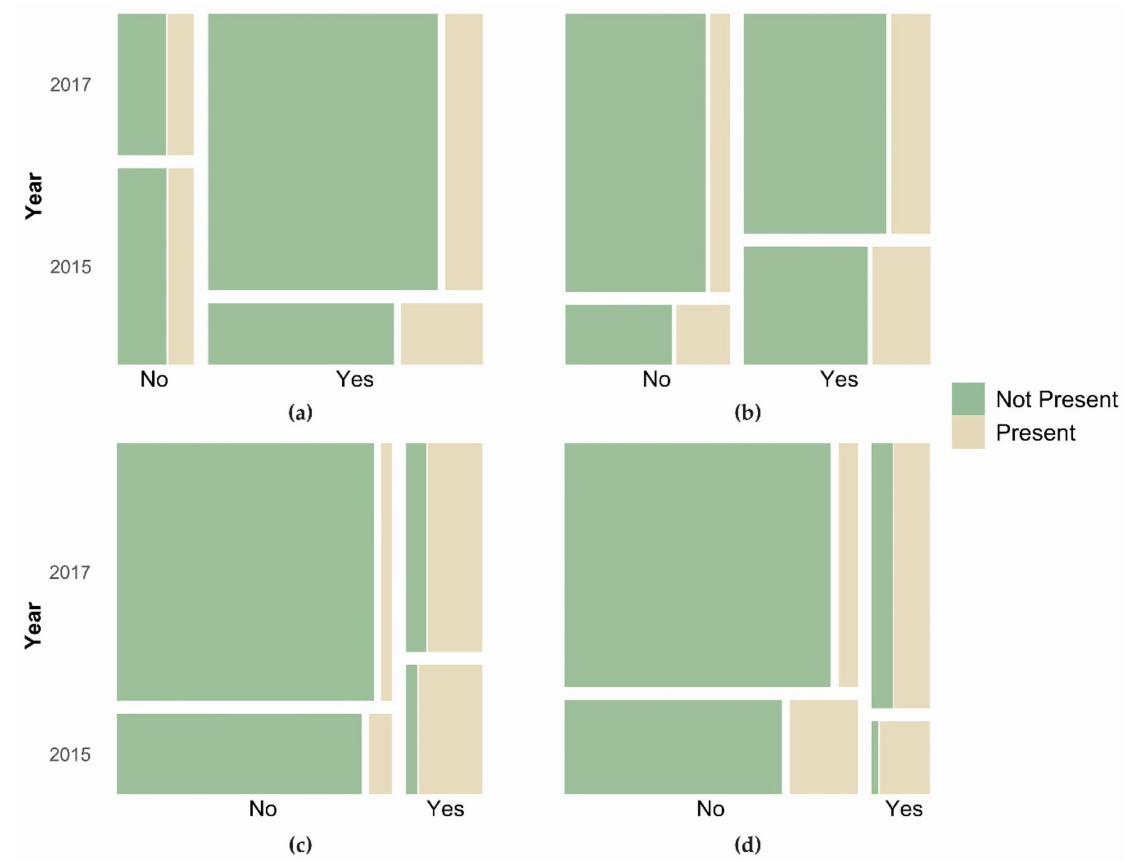
Figure 3. Relationship between year and acceptance of hippos based on whether respondents noted that hippos ( a ) caused human casualties, ( b ) disrupted fishing activities, ( c ) should be protected, and ( d ) provided one or more